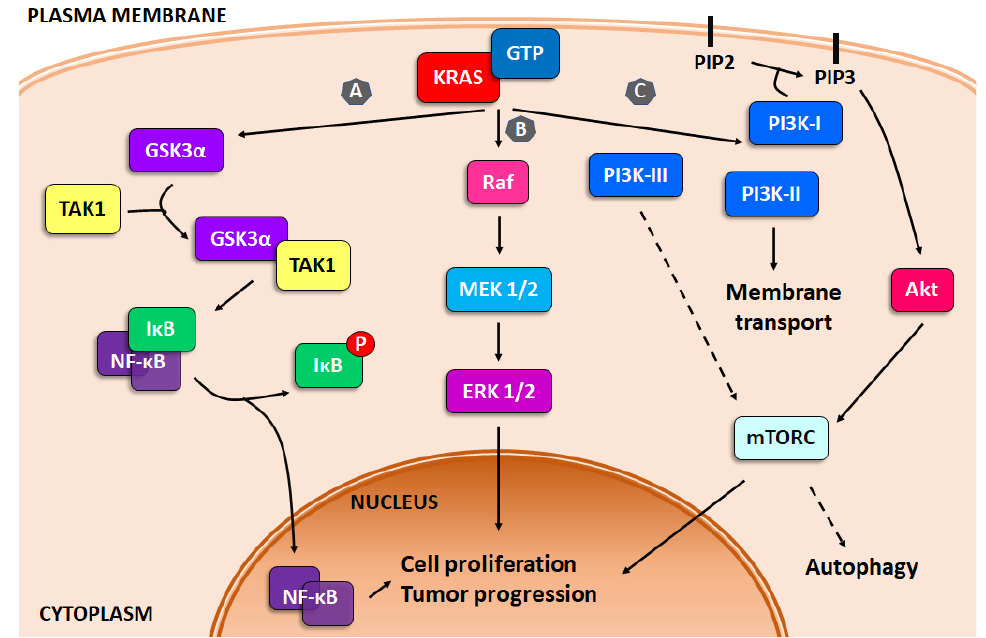
Figure 1. KRAS signaling. Schematic representation of the three main survival pathways upregulated by KRAS mutations. ( A ) NF- κ B, ( B ) MAPK and ( C ) PI3K pathways.